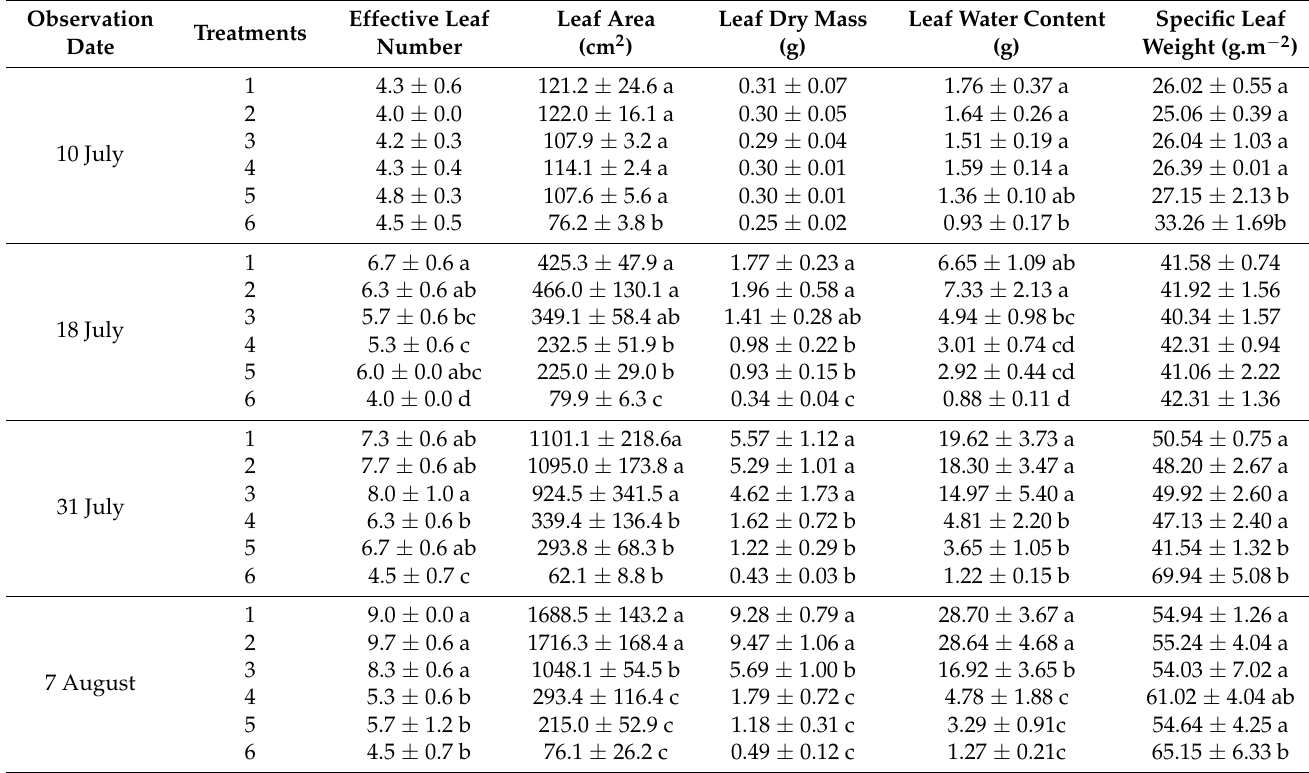
Table 2. Leaf traits of maize plants in each